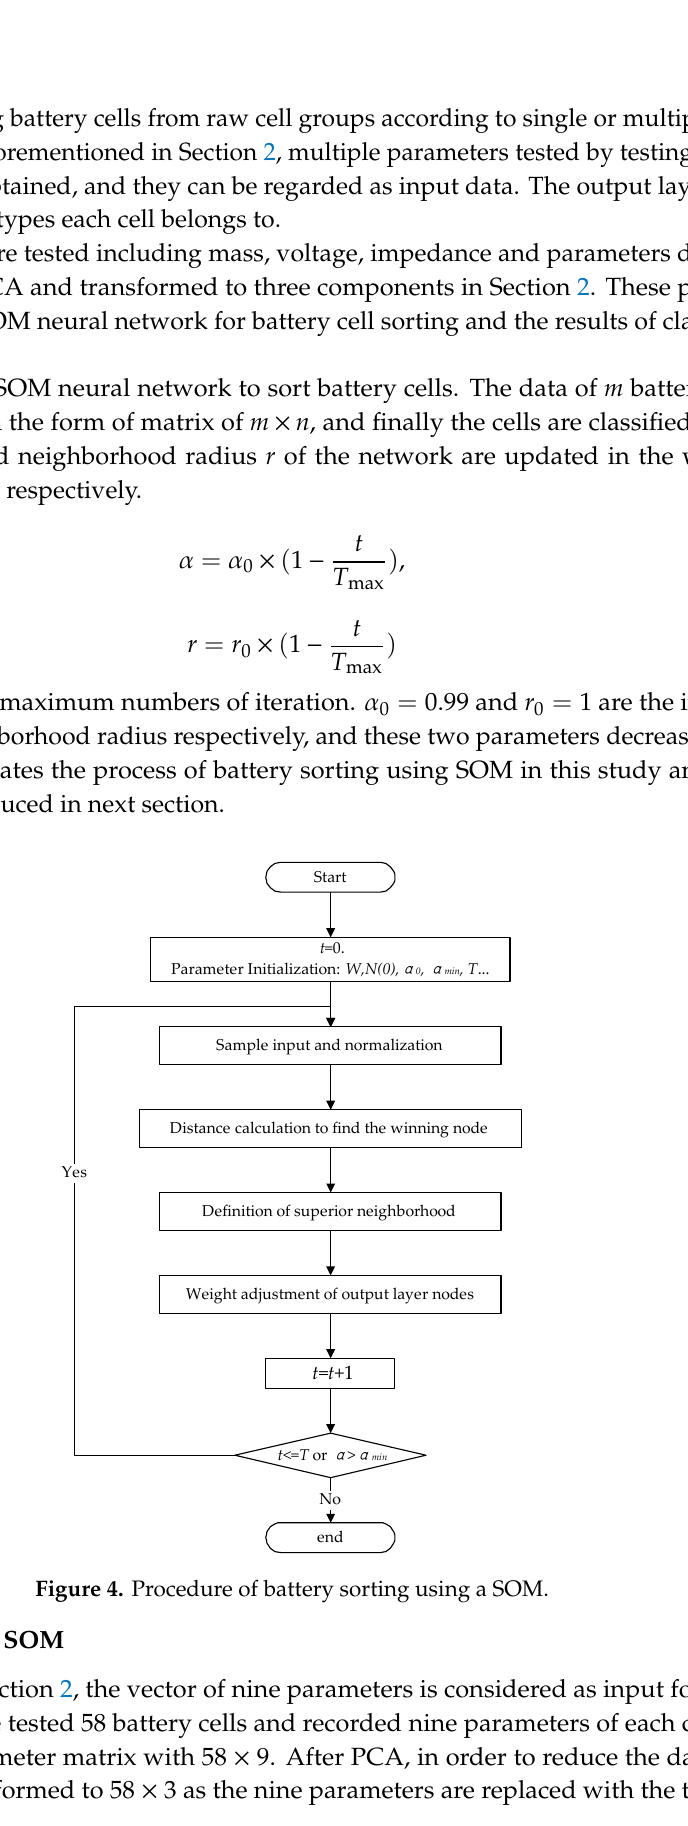
Table 4. Examples of principal component scores for eight batteries (Group 2).